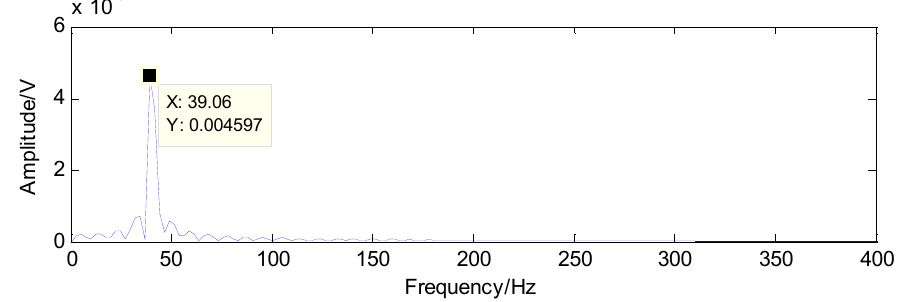
Figure 25. The detected fault characteristic frequency through matching pursuit. Sensors 2016 , 16 , 1524